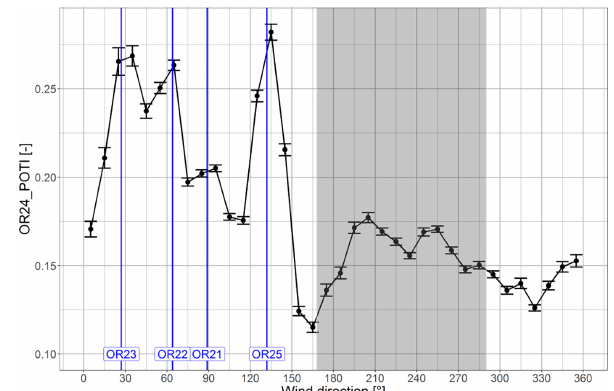
Figure 17. The signal PO TI is sensitive to wake-induced turbulence from neighbouring turbines and wind farms. With PO TI from tur- bine OR24 it is even possible to rank the distance of the neighbours, with OR25 being the closest at 4.2D and OR21 the farthest at 9.1D.